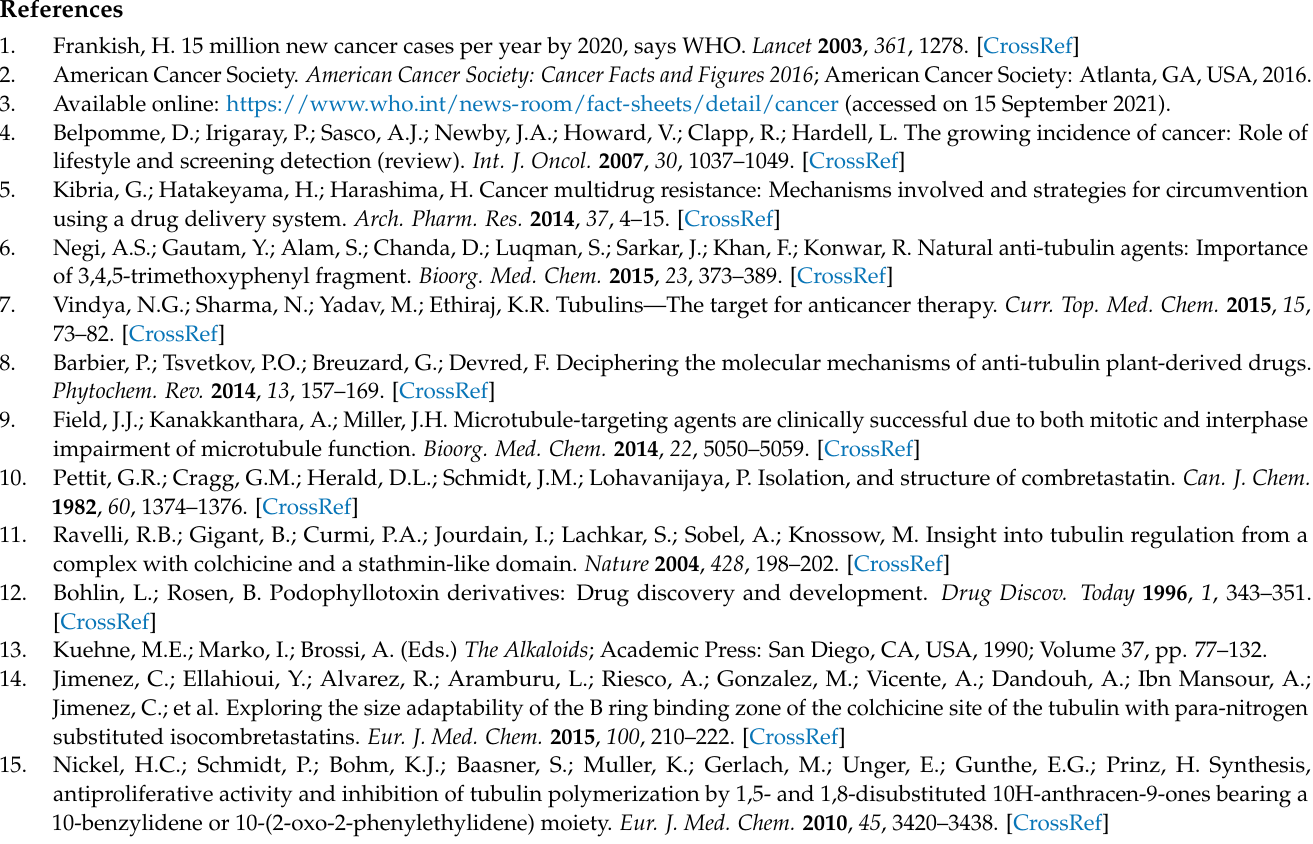
en-1-one; Figure S14: Mass spectra of ( E )-3-(3-(4-(benzyloxy)phenyl)-1-phenyl-1 H -pyrazol-4-yl)-1-(4- methoxyphenyl)prop-2-en-1-one; and Figure S15: Effect of lead conjugates 5d , 5e , 5i , 5k , 5l , 5m , 5n , 5o , 5p , and 5r on tubulin polymerization. Tubulin polymerization was monitored by the increase in fluorescence at 360 nm (excitation) and 420 nm (emission) for 1 h at 37 ◦ C. Combretastatin A-4 was used as the reference standard in this